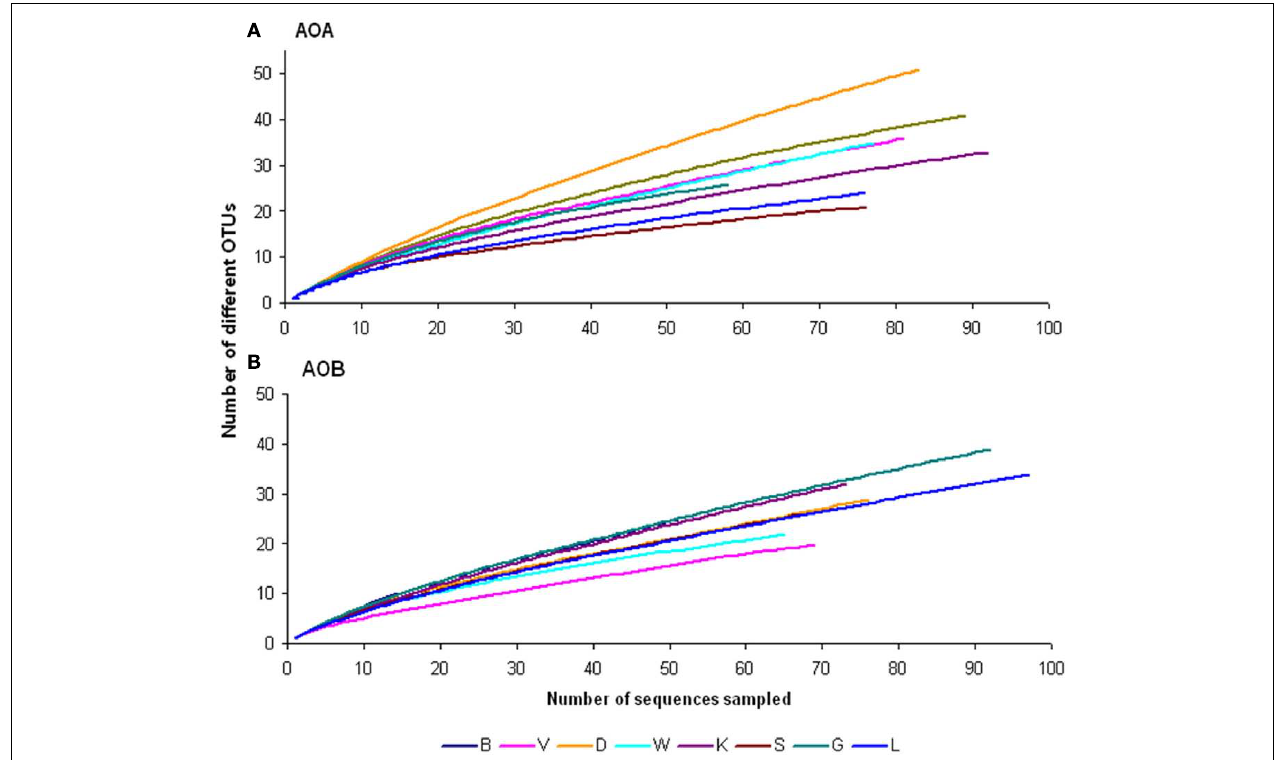
FIGUREA5 | Rarefaction curves of observed operational taxonomic units (OTU) based on archaeal (A) and bacterial (B) amo A sequences retrieved from the eight soils, determined by DOTUR (Schloss and Handelsman, 2006). See legend from Figure 1 for soil names.